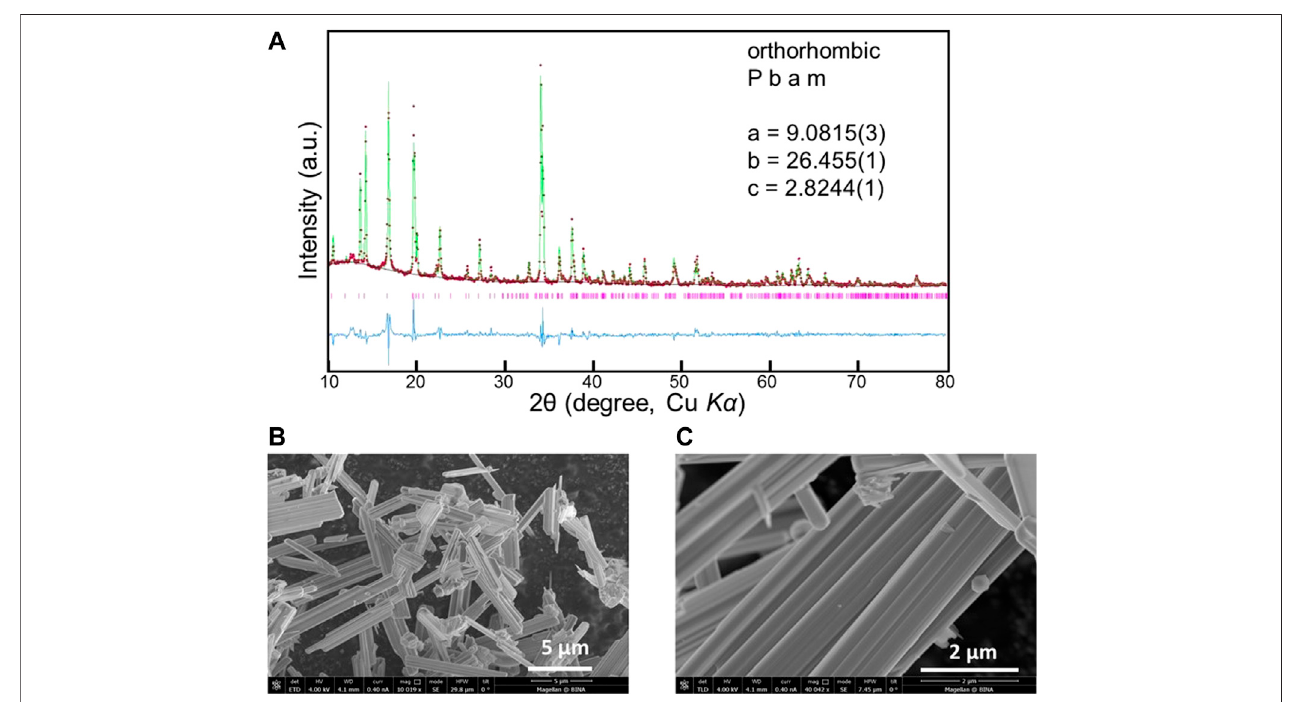
FIGURE 3 | (A) Powder XRD Rietveld re fi nement pro fi le for Na 0.44 MnO 2 (red points: experimental data. green line: calculated data. blue line: difference. pink bars: Bragg positions). (B) HRSEM images at magni fi cation of × 10k at 5 µm range and (C) × 40k at 2 µm range.